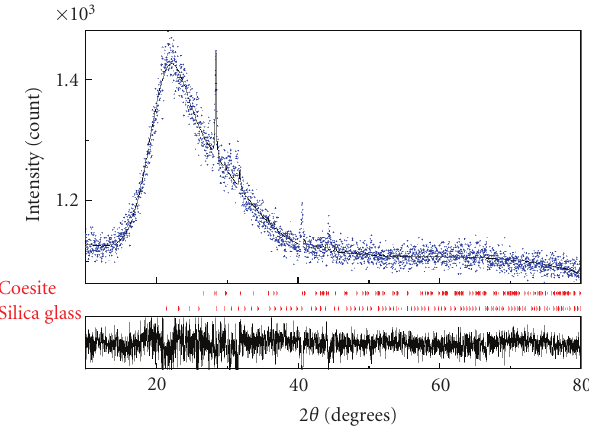
Figure 4: Experimental X-ray di ff raction pattern of the sample heat-treated at 600 ◦ C together with the fitted spectrum. The di ff erence is showed in the bottom of the